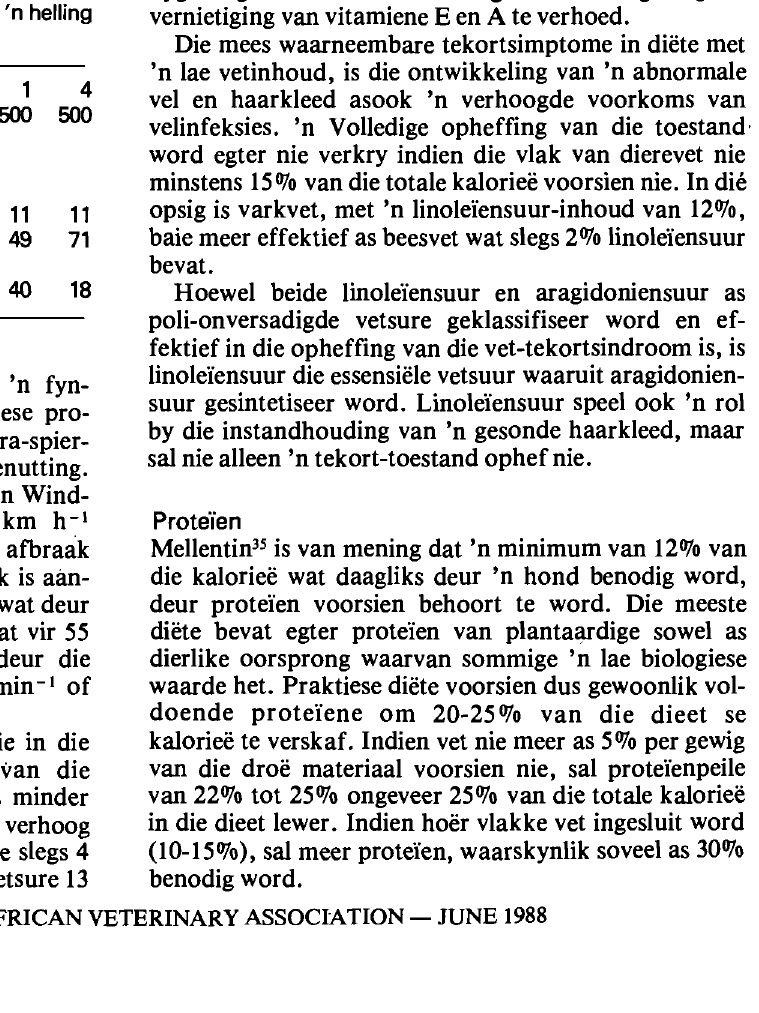
Tabel 4: Suurstofverbruik en relatiewe bydrae van glukose